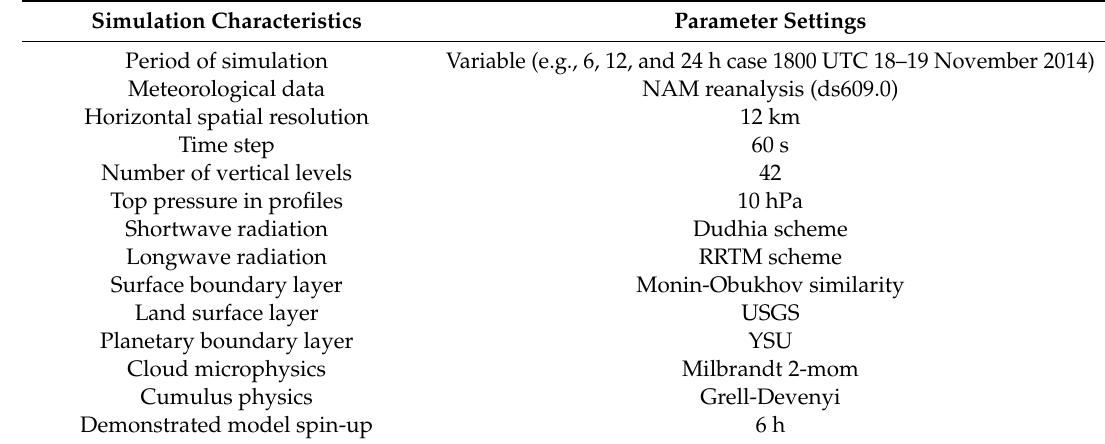
Table 1. Weather Research and Forecasting (WRF) ver. 3.7.1 simulation configuration for verification of cloud cover